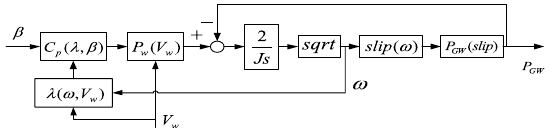
Fig. 4 Structure model of